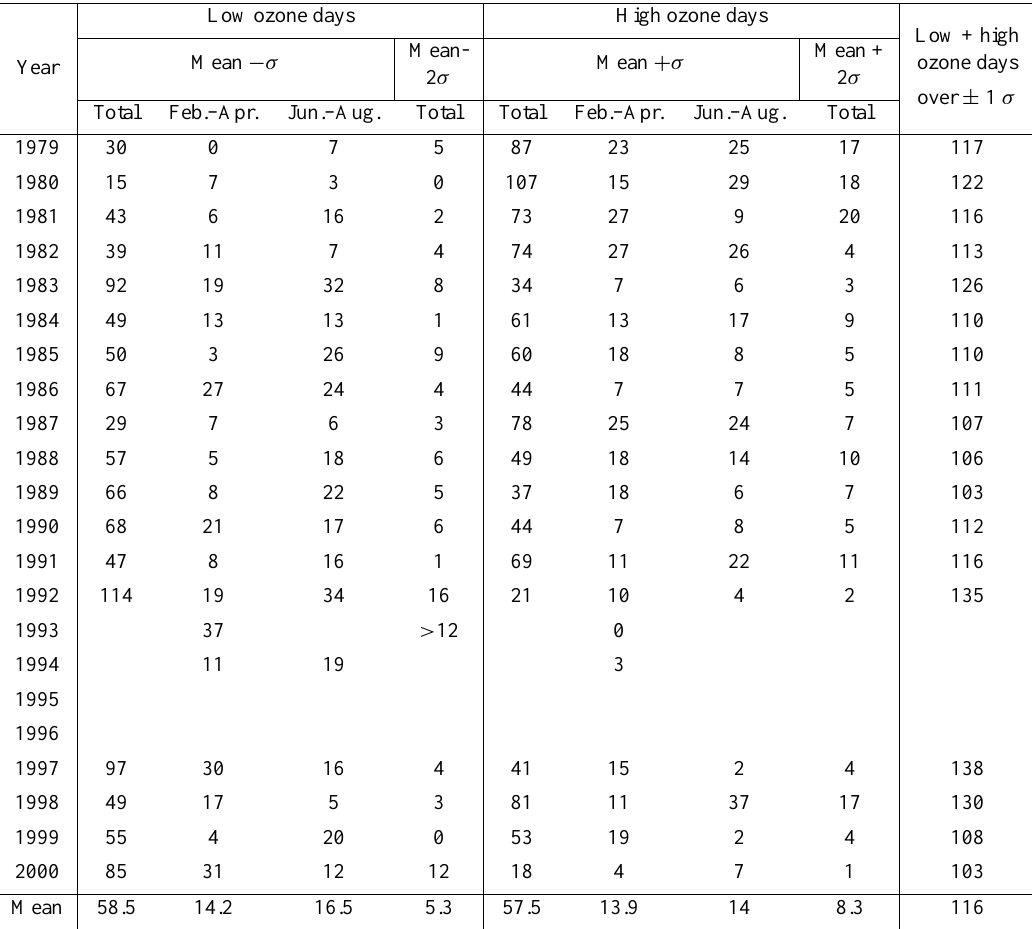
Table 2. Yearly numbers of low and high ozone